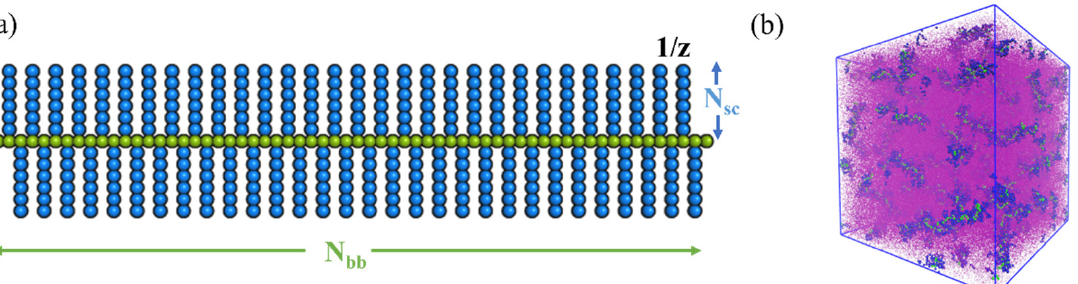
Figure 1. ( a ) Bottlebrush architecture, backbone (bb), and side chain (sc) beads are shown in green and blue, N bb and N sc denote numbers of beads within the backbone and side chain, respectively. ( b ) Initial distribution of n MBB = 77 bottlebrushes equilibrated within the good solvent; solvent beads are shown in purple using reduced bead size.